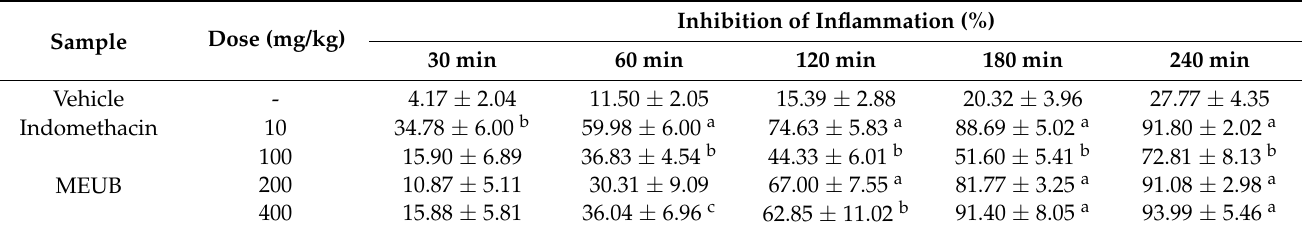
Table 5. Effects of MEUB on carrageenan-induced mice hind paw edema ( n = 5).